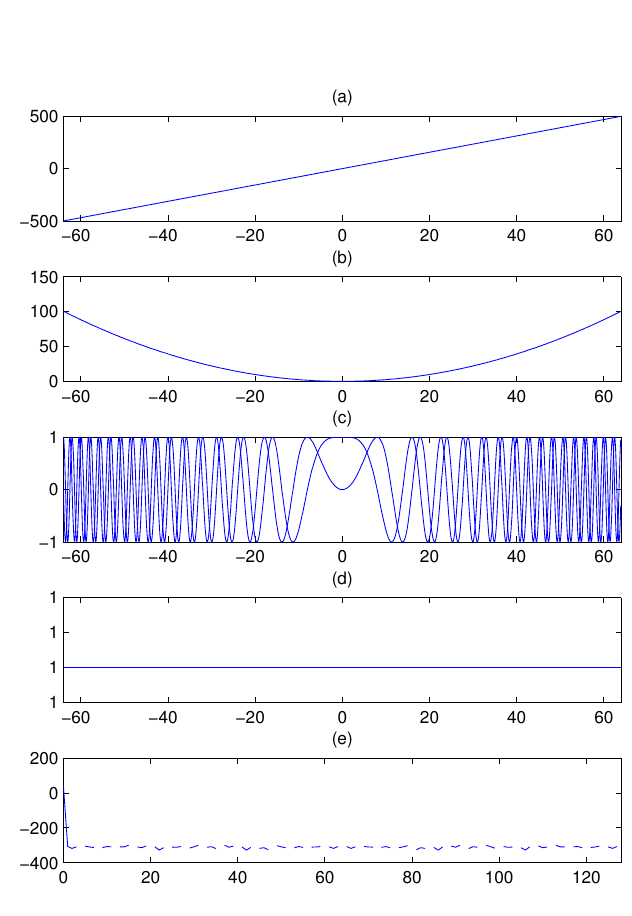
Figure 3. Up raw chirp : (a) frequency evolution during the chirp, (b) the corresponding instantaneous phase, (c) varying period of the phase and quadrature components, (d) the output of the matched filter and (e) its